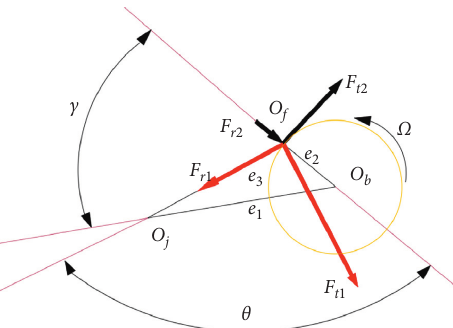
Figure 2: Force diagram for floating